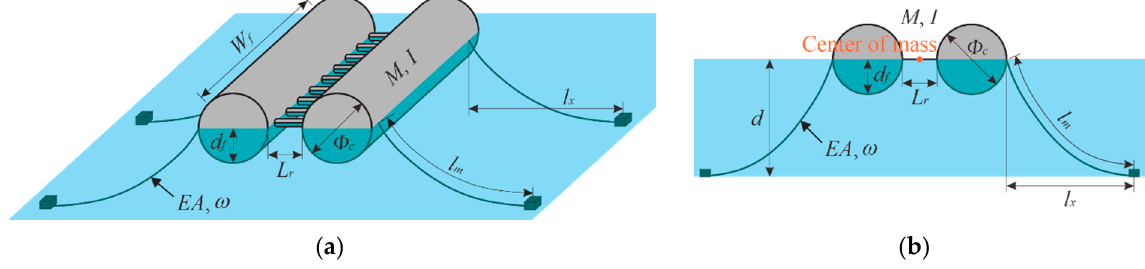
Figure 8. Setup of the dual cylindrical floating pontoon and its mooring system: ( a ) Physical model; ( b ) Numerical model. Table 2. Parameters of the dual cylindrical floating pontoon.